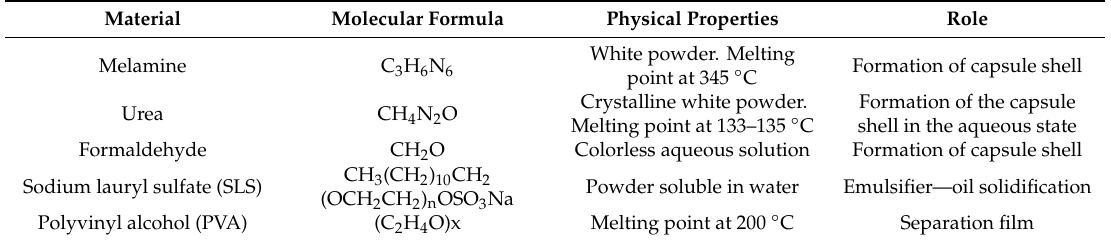
Table 3. Chemical substances used in the production of melamine-urea-formaldehyde (MUF) microcapsules with embedded 5-ethylidene-2-norbornene